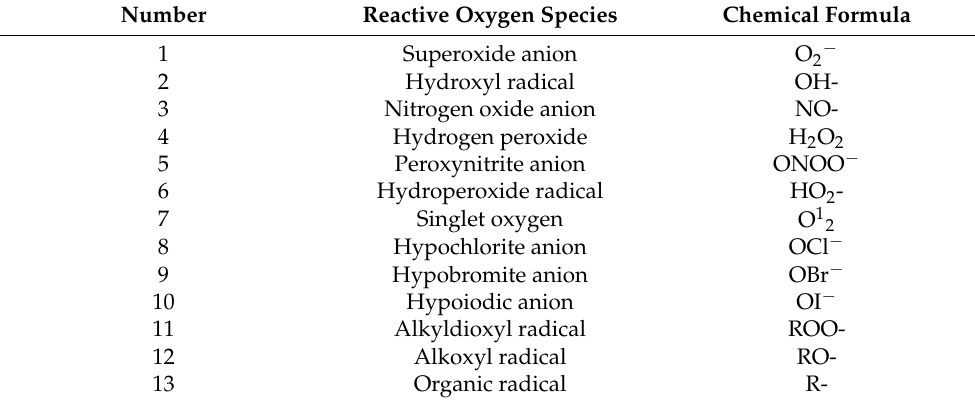
Table 1. Reactive oxygen species